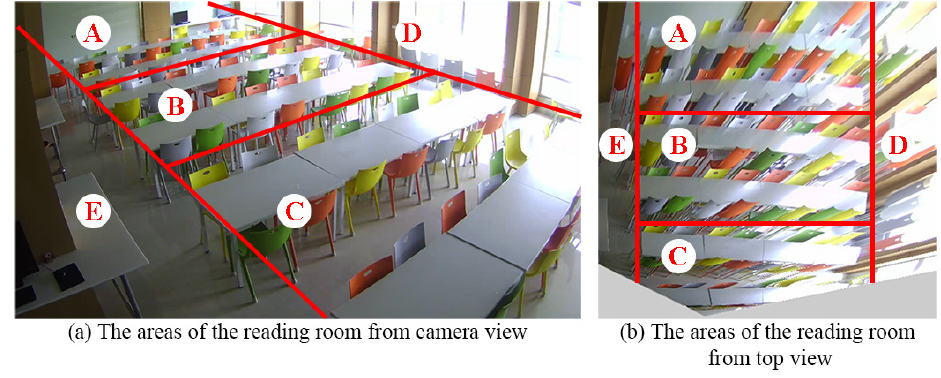
Figure 16. Labeling areas in the reading